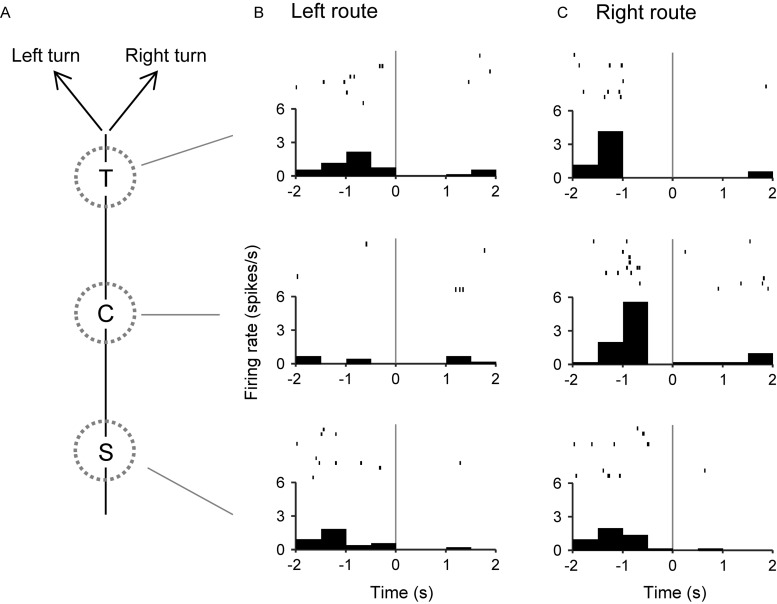
An example of a route-dependent reward-related neuron in the VN task. (A) Schematic illustration of the left and right routes in the common central hallway. (B,C) Three peri-event time histograms and raster plots around reward delivery at the T-, C-, and S-reward areas in the left (B) and right (C) routes. Gray lines indicate reward delivery.